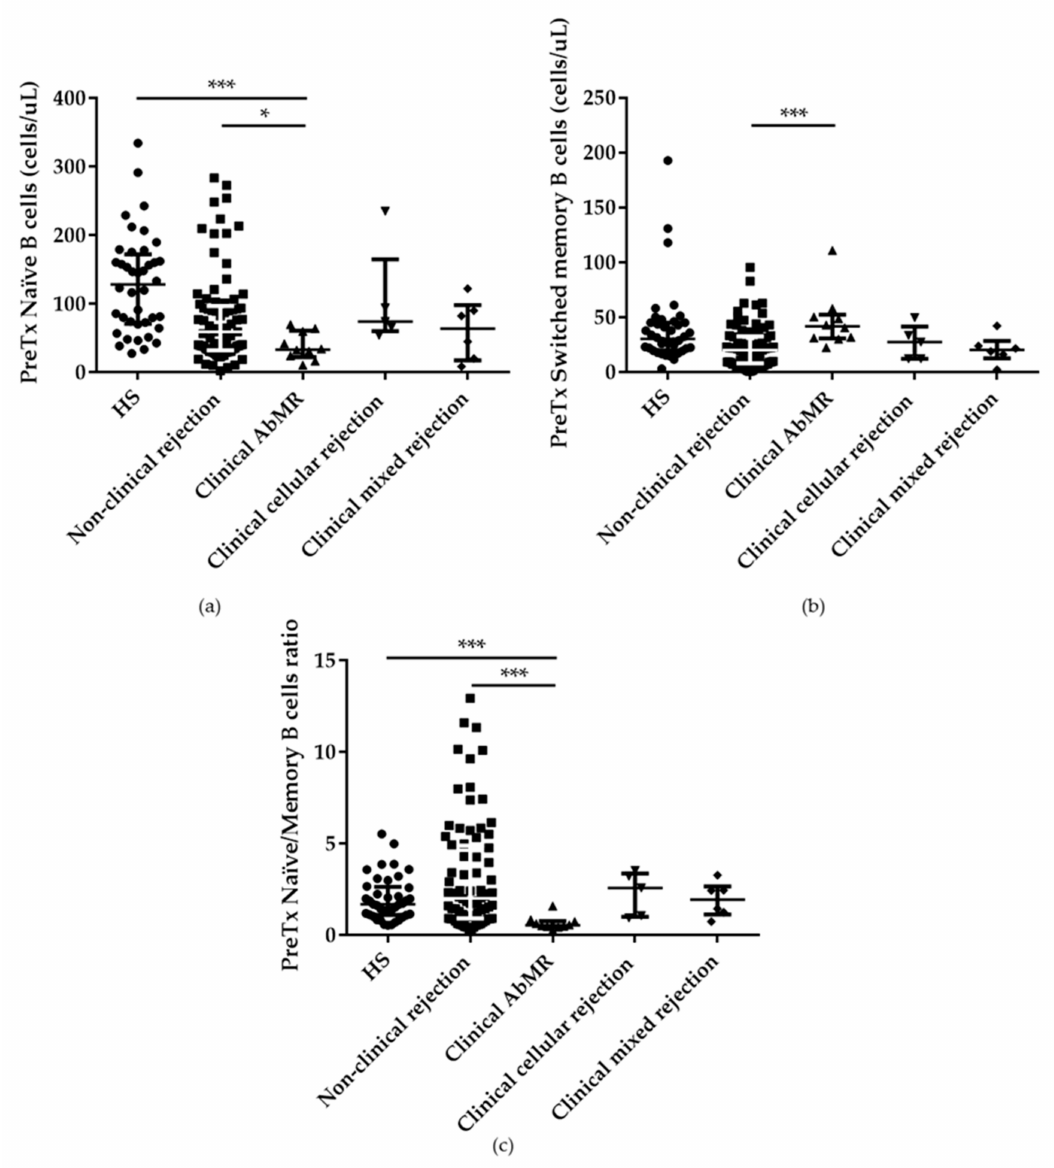
Figure 4. Abnormal ratio between pretransplant naïve and memory B cells. ( a ) Significant reduction of absolute numbers of naïve B cells in antibody-mediated rejection (AbMR) patients ( n = 11). ( b ) Higher numbers of switched memory B cells in patients that developed AbMR. ( c ) Reduction of pretransplant naïve / memory B cells ratio between AbMR patients and non-clinical rejection group ( n = 87) and healthy subjects (HS; n = 40). * indicates p < 0.05, and *** p <